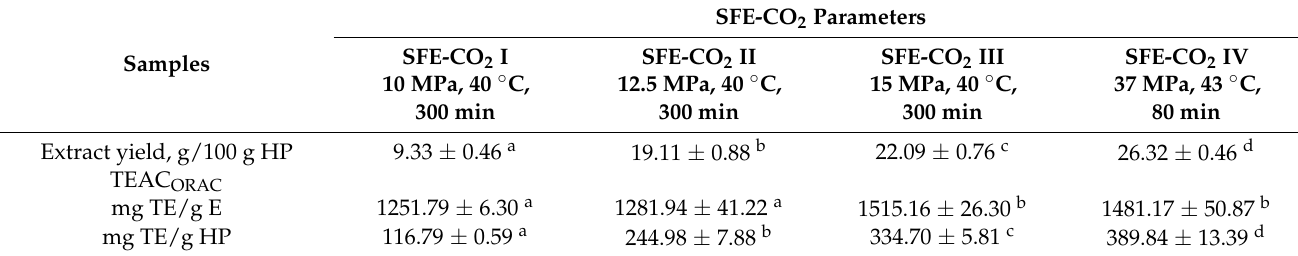
Samples Samples